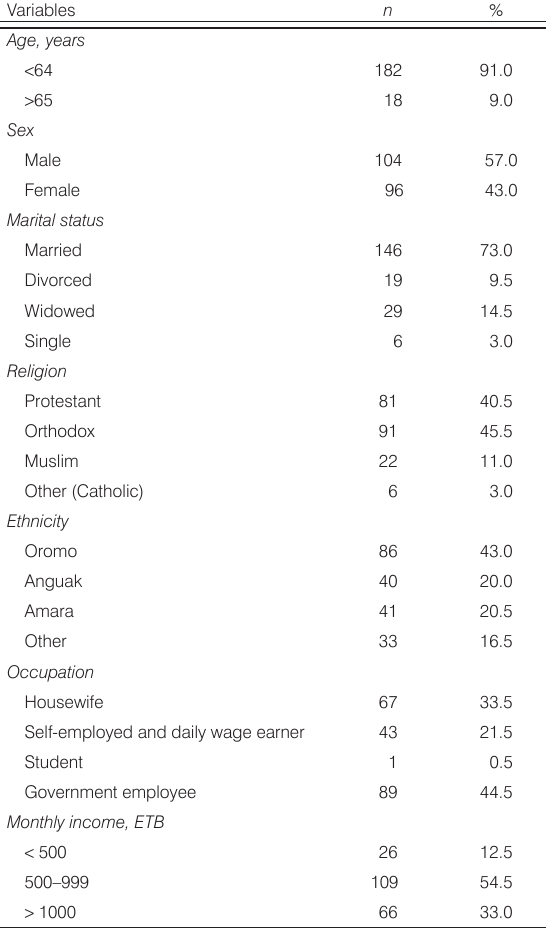
Table 1. Sociodemographic characteristics of hypertensive